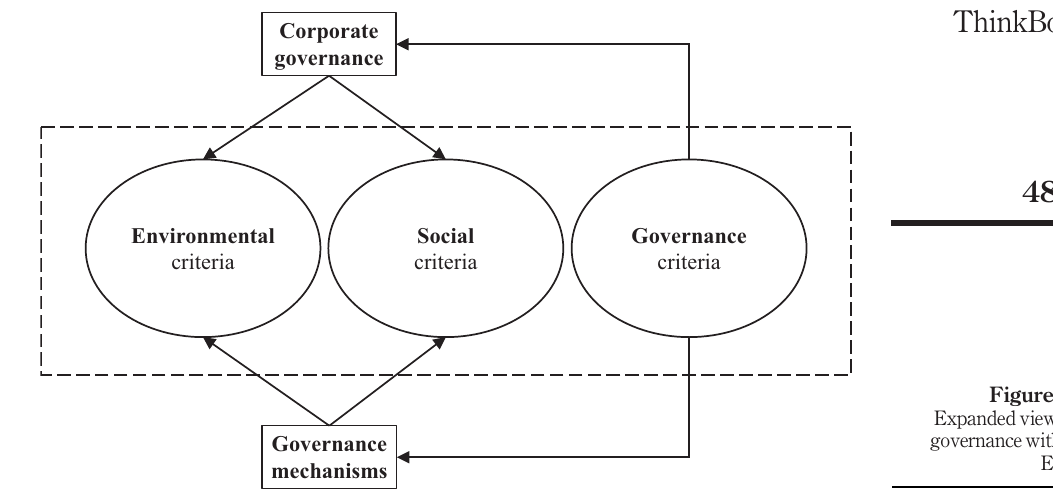
Figure 1. Expandedview